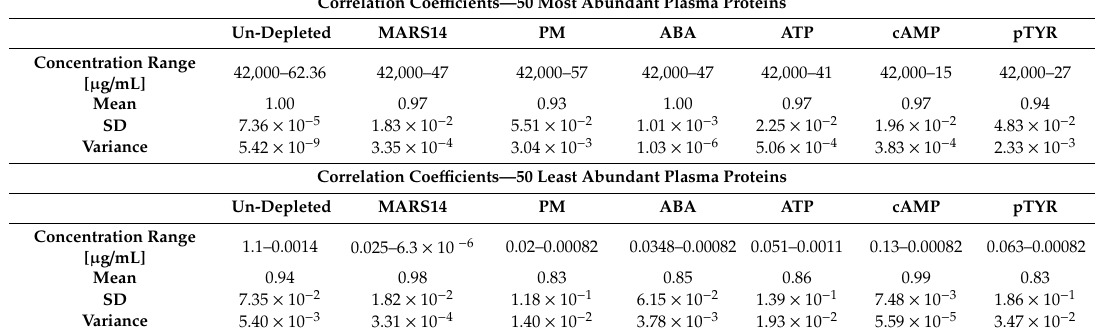
Table 2. Reproducibility of the MARS14 depletion, the Proteominer protein equalization, and the ATP-, cAMP-, pTYR-, and ABA a ffi nity-based enrichment methods. The reproducibility of six replicates of the methods were assessed based precursor ion area detection of identified proteins from individual LC-MS / MS runs and evaluated by linear correlations analysis. The concentrations of the measured proteins in plasma were based on values extracted from the plasma proteome database (http: // www.plasmaproteomedatabase.org). The 50 proteins that were annotated with the highest concentrations and the 50 proteins with the lowest concentrations, according to the plasma proteome database, were included in the correlation